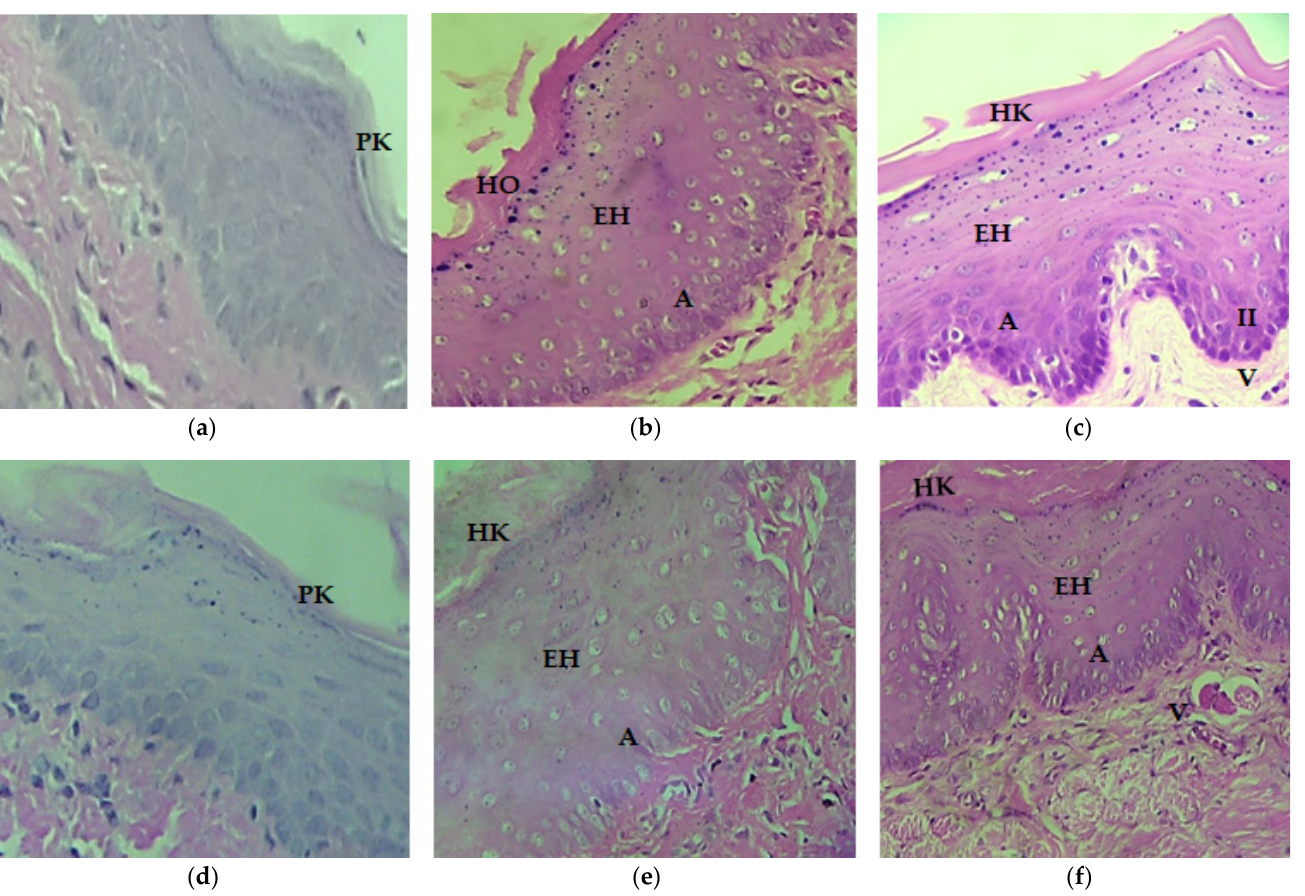
results are the average of the observed samples ( n = 5).